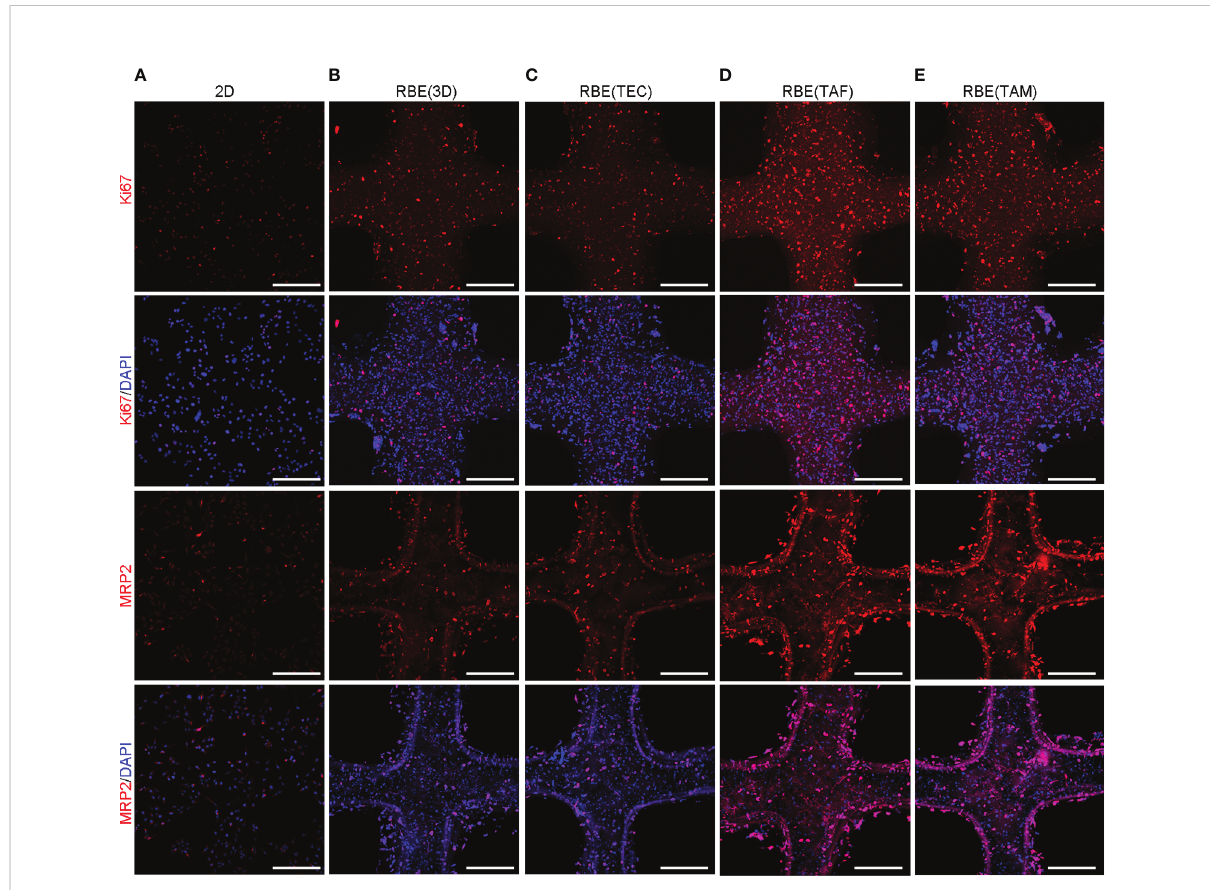
FIGURE 3 Correlative protein expression by immuno fl uorescence (IF) in different models. (A – E) The expression of Ki67, MRP2 at 7 days after 3D bioprinting and 2D cells with appropriate density. Compared with 2D environment, 3D bioprinted environment promoted genes expression. While RBE(TAF) and RBE(TAM) had higher expression than that in RBE(3D) and RBE(TEC). Scale bars: 40 m m. The experiments were replicated at least three